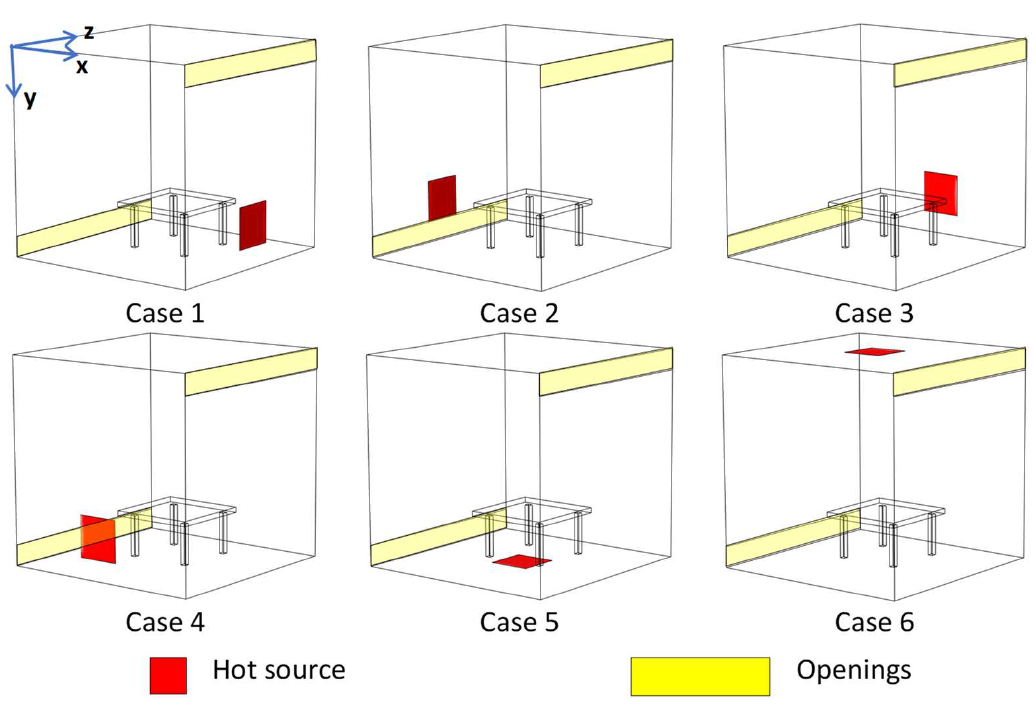
Figure 1. Studied configurations.